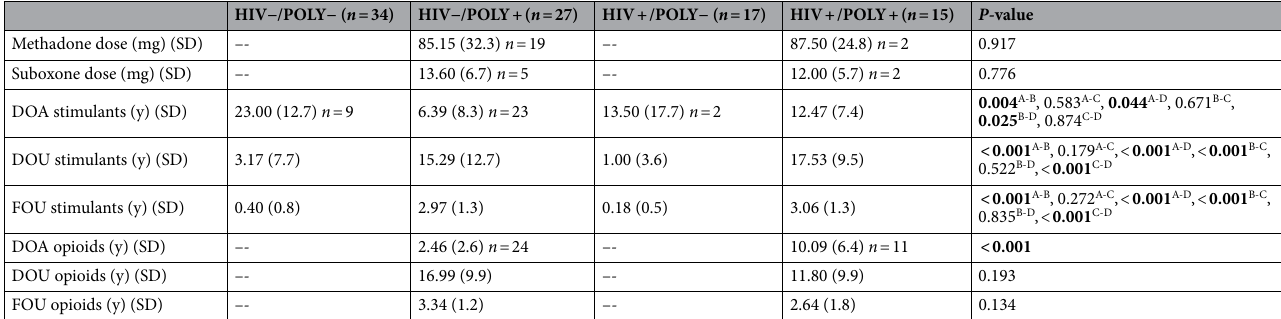
Table 3. Stimulant and opioid variables across groups. Statistics are reported as in Table 1. Post-hoc comparisons included: A = HIV-/POLY-, B = HIV-/POLY + , C = HIV + /POLY-, D = HIV + /POLY + . DOA = duration of abstinence, DOU = duration of use, FOU = frequency of use, SD = standard deviation, mg = milligram, y = years. Significant values are in [bold], p <